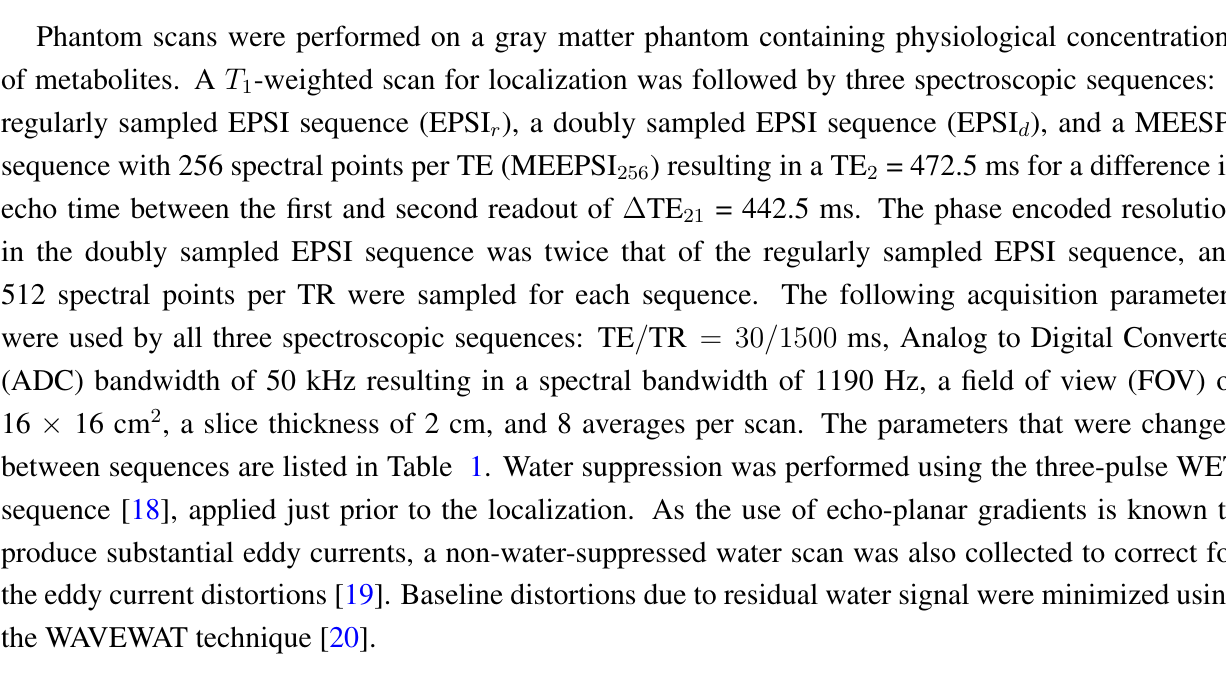
Table 1. Varying phantom scan parameters. Fixed parameters were: TE / TR = 30 / 1500